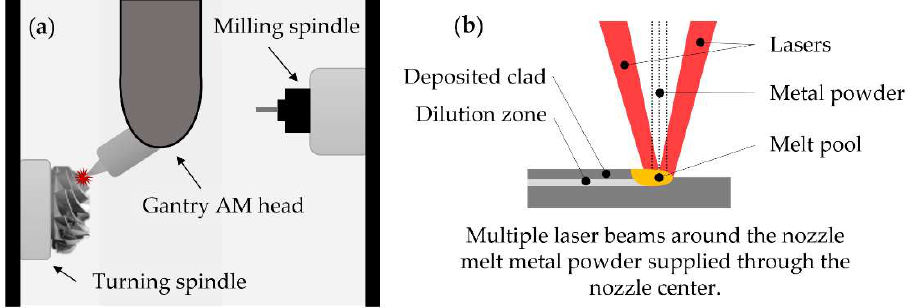
Figure 8. ( a ) Gantry AM head used in the INTEGREX i-200S ; ( b ) Multi-Laser Deposition process. [118].